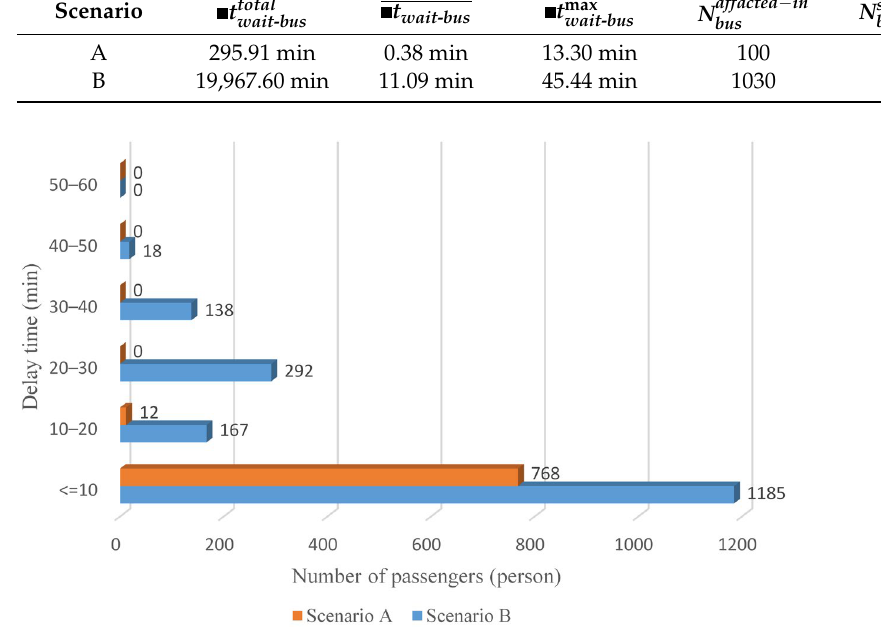
Figure 13. Delay time distribution of original bus passengers.